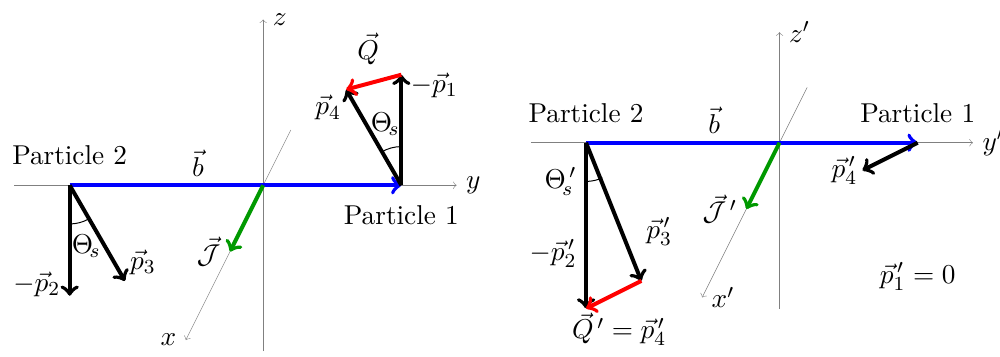
Figure 1 . Coordinate choices in the two reference frames discussed in the text: the centre-of-mass frame (left panel) and the frame where particle 1 is initially at rest (right